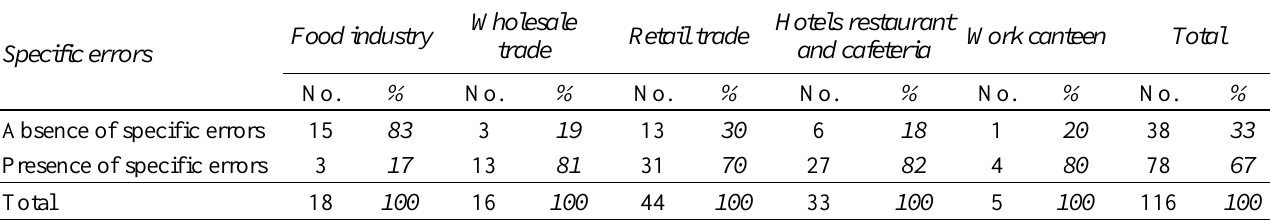
Table 5: Presence of specific errors in the level HACCP, for class of activity of the food companies. Specific errors